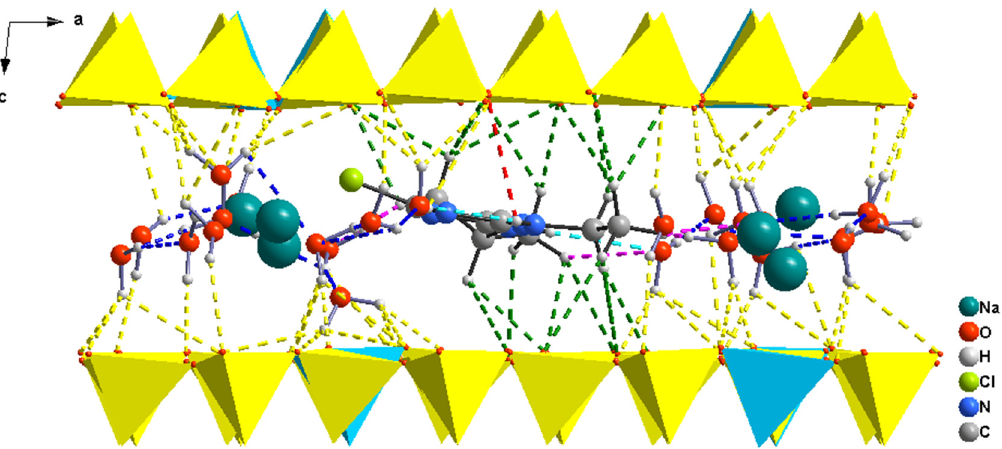
Figure 3. The hydrogen bonds in the A-Bd model as an example: green (C–H ··· O b ), magenta (C–H ··· O w ), yellow (O w – H ··· O b ), blue (O w –H ··· O w ), cyan (N–H ··· O w ) and red (N–H ··· O b ); b -view. Only tetrahedral sheets are illustrated for better viewing of the hydrogen